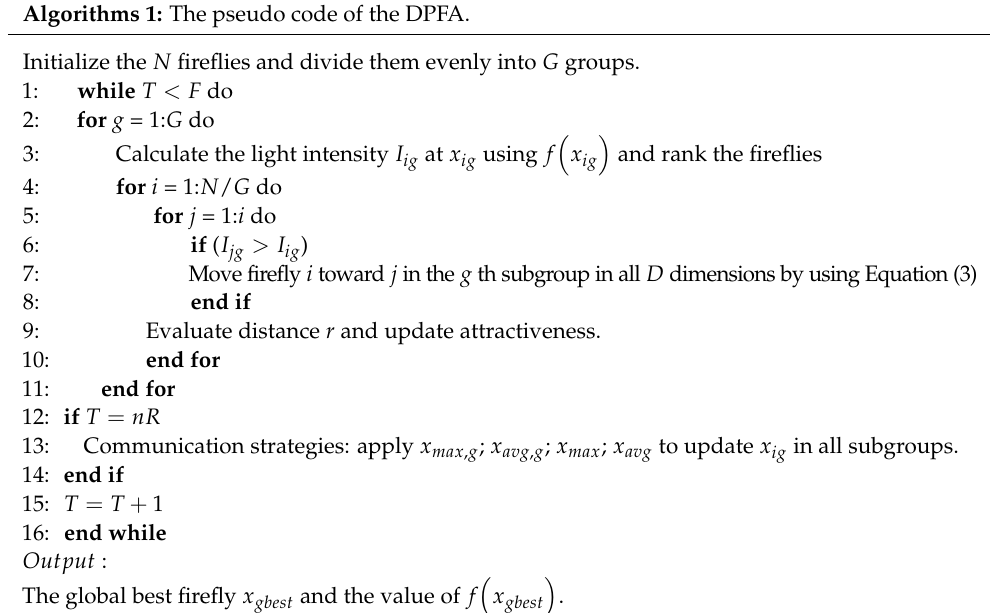
Table 1. The orthogonal array L 9 Number of